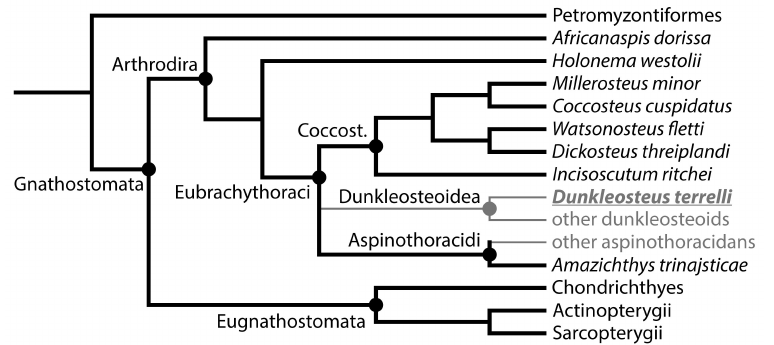
Figure 3. Phylogeny of taxa considered in this study. Taxa with known body lengths are listed in black, those where body length is unknown are listed in gray. Arthrodire phylogeny follows Zhu et al. [23], Boyle and Ryan [22], and Jobbins et al. [21]. Abbreviations: Coccost.,